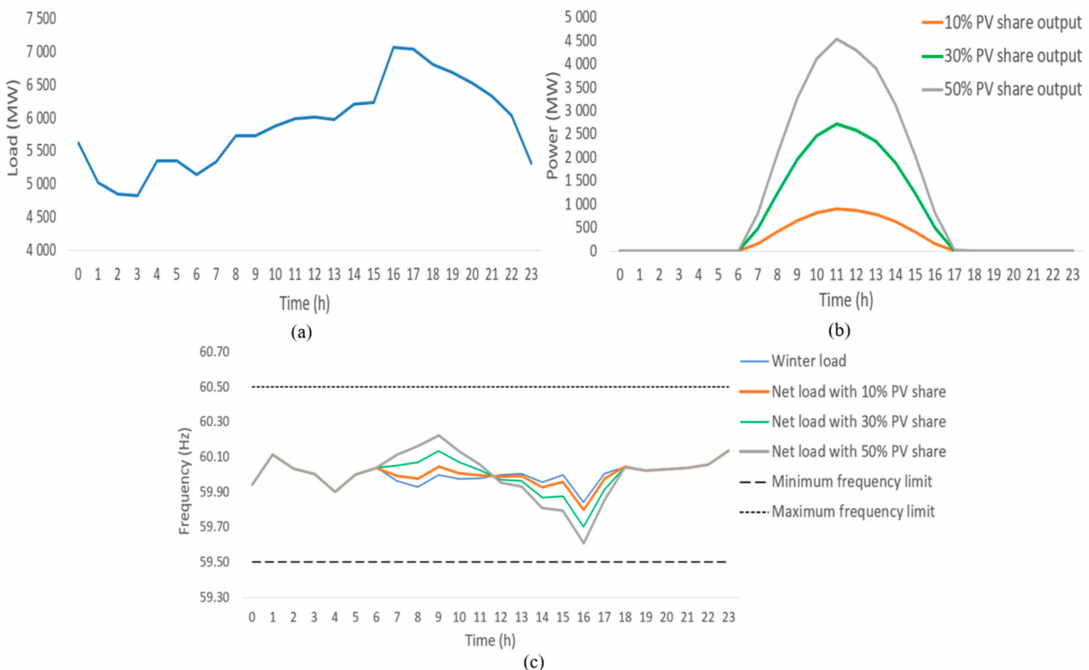
Figure 16. ( a ) January’s average hourly daily load profile of Riyadh, 2017; ( b ) January’s PV output at various share capacities in Riyadh, 2017; ( c ) grid frequency representation of the January load of Riyadh, 2017, with the inclusion of the PV system at various capacities without grid constraints.